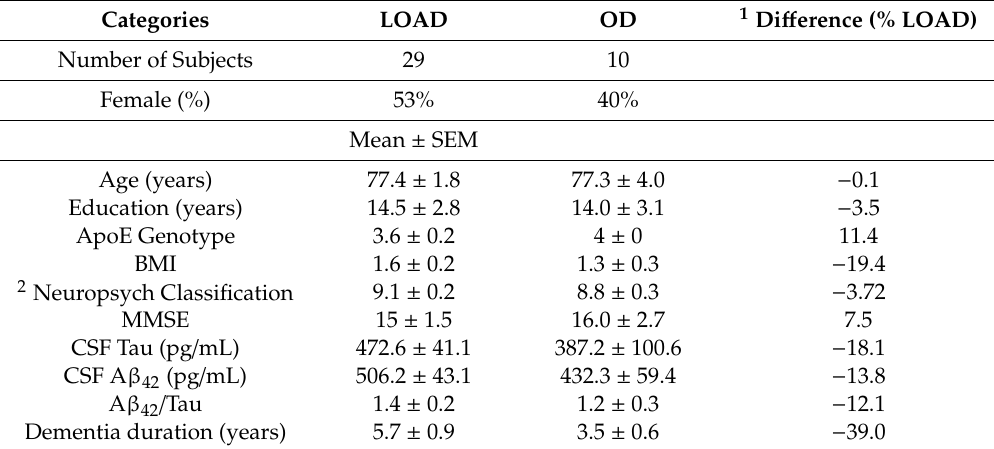
Table 1. Demographics and CSF biomarkers of LOAD and OD.